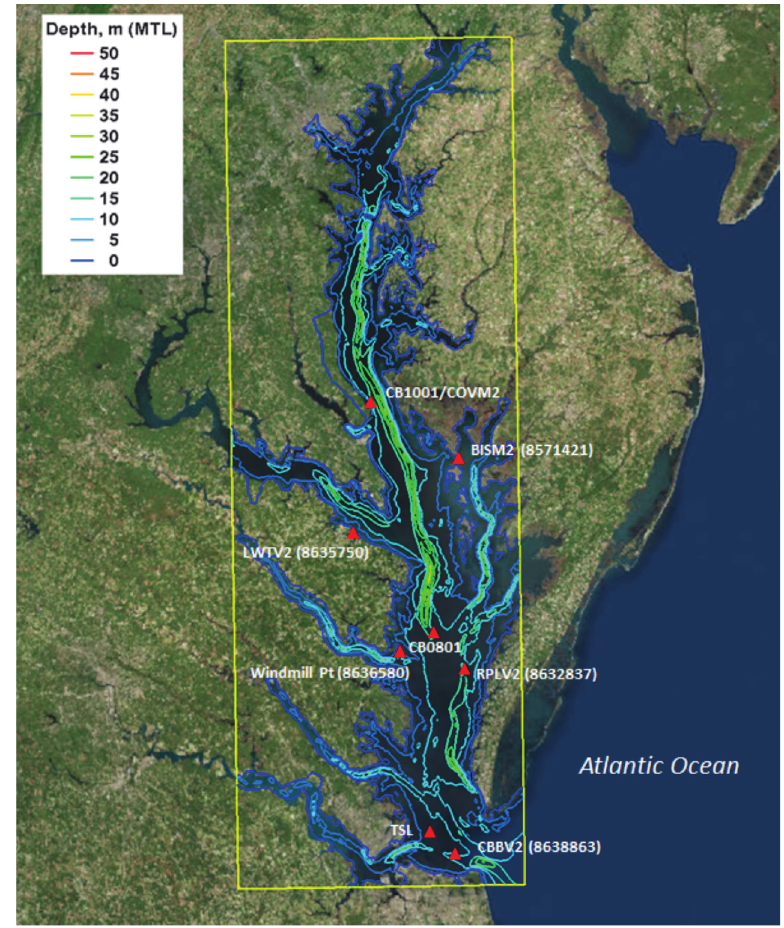
Figure 6. NOAA and VIMS coastal stations (red triangle) and CMS depth contours (m, MTL) for the CMS Chesapeake Bay regional grid domain (yellow